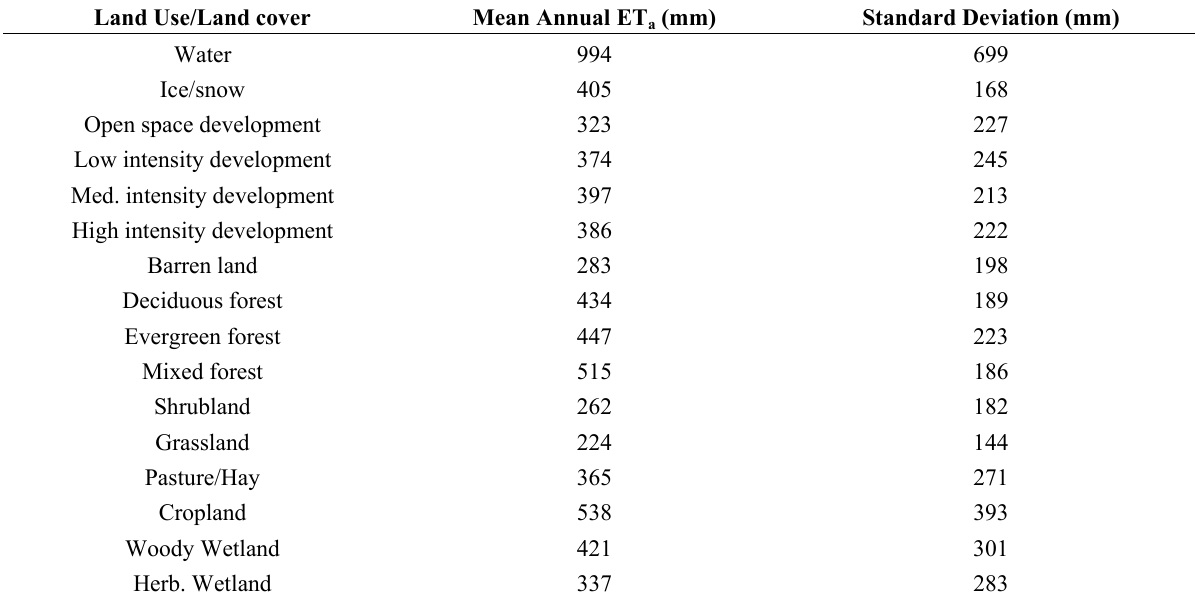
Table 3. Annual evapotranspiration (mm) during 2010 for different National Land Cover Database [24] land use/land cover within the study area.